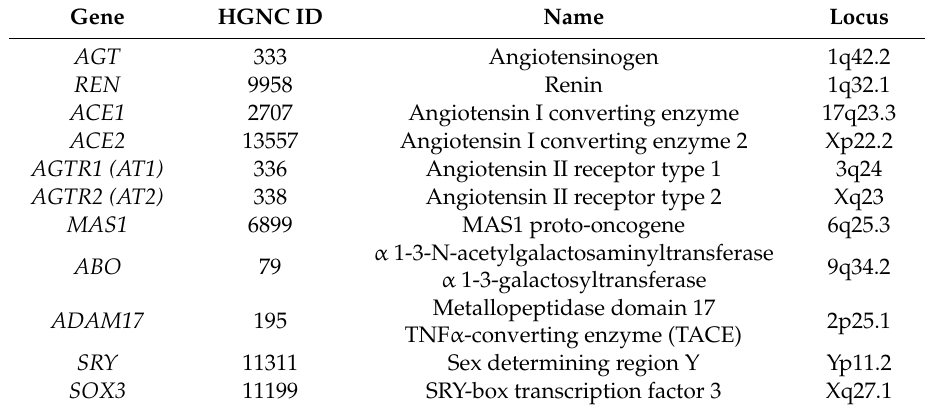
Table 1. Main genes directly or indirectly involved in the Renin Angiotensin System homeostasis. Gene HGNC ID Name Locus AGT 333 Angiotensinogen 1q42.2 REN 9958 Renin 1q32.1 ACE1 2707 Angiotensin I converting enzyme 17q23.3 ACE2 13557 Angiotensin I converting enzyme 2 Xp22.2 AGTR1 (AT1) 336 Angiotensin II receptor type 1 3q24 AGTR2 (AT2) 338 Angiotensin II receptor type 2 Xq23 MAS1 proto-oncogene 6q25.3 α 1-3-N-acetylgalactosaminyltransferase ABO 79 9q34.2 α 1-3-galactosyltransferase Metallopeptidase domain 17 ADAM17 195 2p25.1 TNF α -converting enzyme (TACE) SRY 11311 Sex determining region Y Yp11.2 SOX3 11199 SRY-box transcription factor 3 Xq27.1 HGNC: Human Gene Nomenclature Committee of the Human Genome Organisation